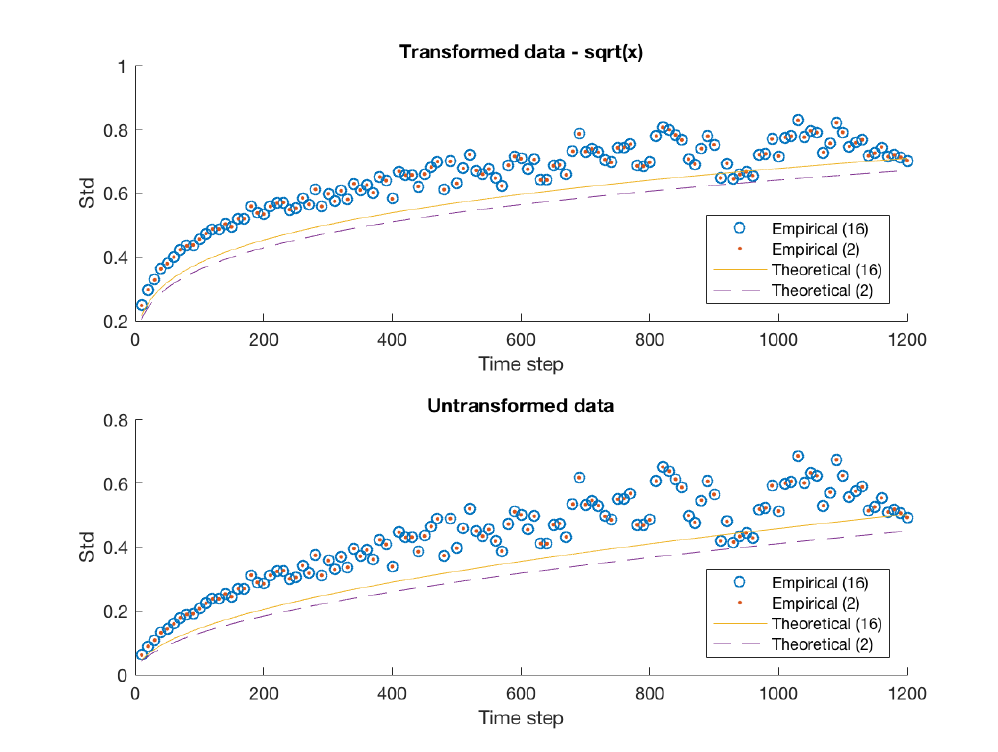
Figure 6. We consider the N-state model for AMZN discussed previously in the paper. While there is a slight improvement against the original fit, the model still struggles to perfectly predict the variability in the mid-price changes of our